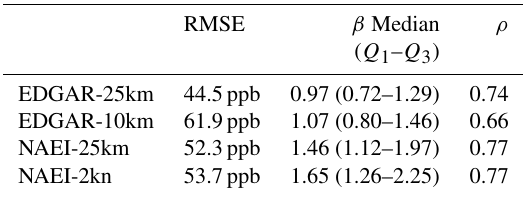
Table 5. Simulation–observation 13:00–17:00 RMSE values, scal- ing factors, and correlation